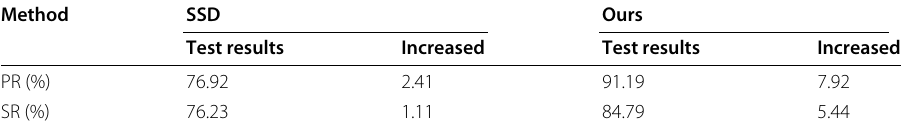
Table 2 Test results after adding training